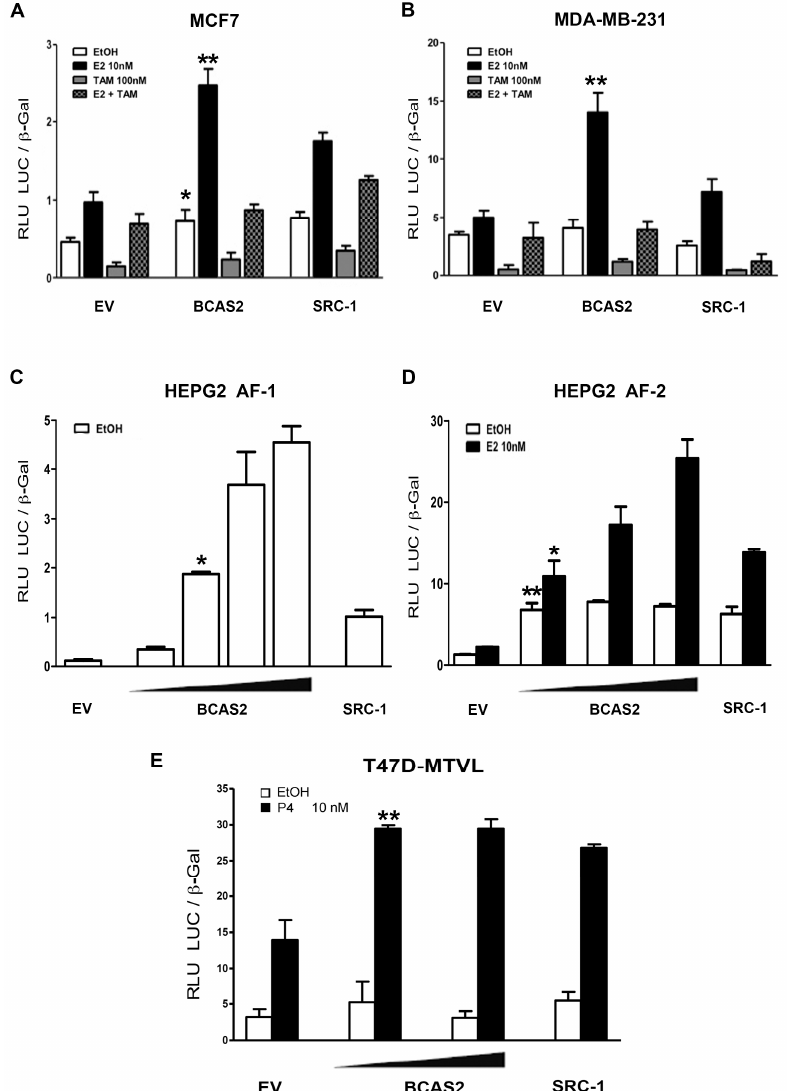
Figure 2. BCAS2 enhances ER α transcriptional activity. Luciferase activity induced by the overexpression of BCAS2 in the presence of ethanol (EtOH), 10 nM E2 or 100 nM TAM ( A , B ). MCF7 cells were transiently transfected with an ERE-luciferase reporter vector (200 ng) and BCAS2 (100 ng). Empty pcDNA3.1 vector (EV) (100 ng) and SRC-1 (100 ng) were transfected as negative and positive controls, respectively. ( B ) MDA-MB-231 cells were transfected with the same plasmids as well as 50 ng of ER α . ( C , D ) BCAS2 enhances AF-1 (aa 1-282) and AF-2 (aa 144-595) transcriptional activation functions, independently. Each plasmid was transfected into HEPG2 cells along with empty vector (EV) or increasing concentrations of BCAS2 (50-200 ng), ERE-luc and β -galactosidase in the presence or absence of 10 nM E2. Transfected SRC-1 coactivator is used as positive control for transcriptional activation. ( E ) BCAS2 activates PR transcriptional activity. Increasing concentrations of BCAS2 (100 and 200 ng), as well as β -galactosidase vector, were transfected into breast cancer T47D cells stably transfected with a luciferase reporter vector for PR activity and treated in the absence (EtOH) or presence of 10 nM P4. SRC-1 is used as positive control. Relative luciferase activity (RLU LUC/ β -gal) is shown as the mean ± SE of a representative assay carried out in triplicate, at least three times. vector (transfected at the same concentration) in the presence and absence of E2, * p < 0.05, ** p <